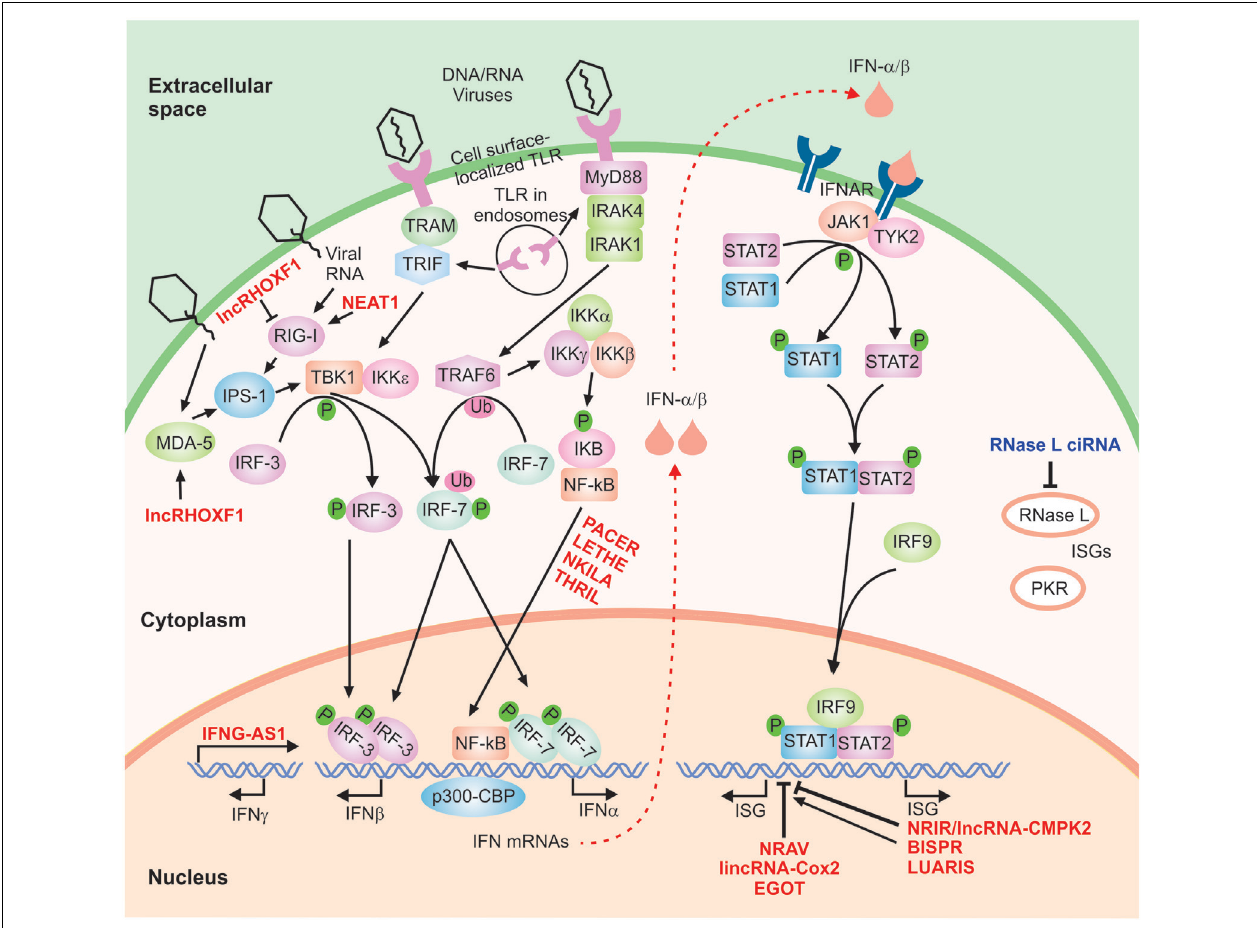
FIGURE 2 | The IFN signaling cascade. A highly simplified scheme of the type I IFN signaling cascade is shown. The host-encoded regulatory lncRNAs are shown in red font. Phosphorylation and ubiquitination events are indicated by small green circles and pink ovals,